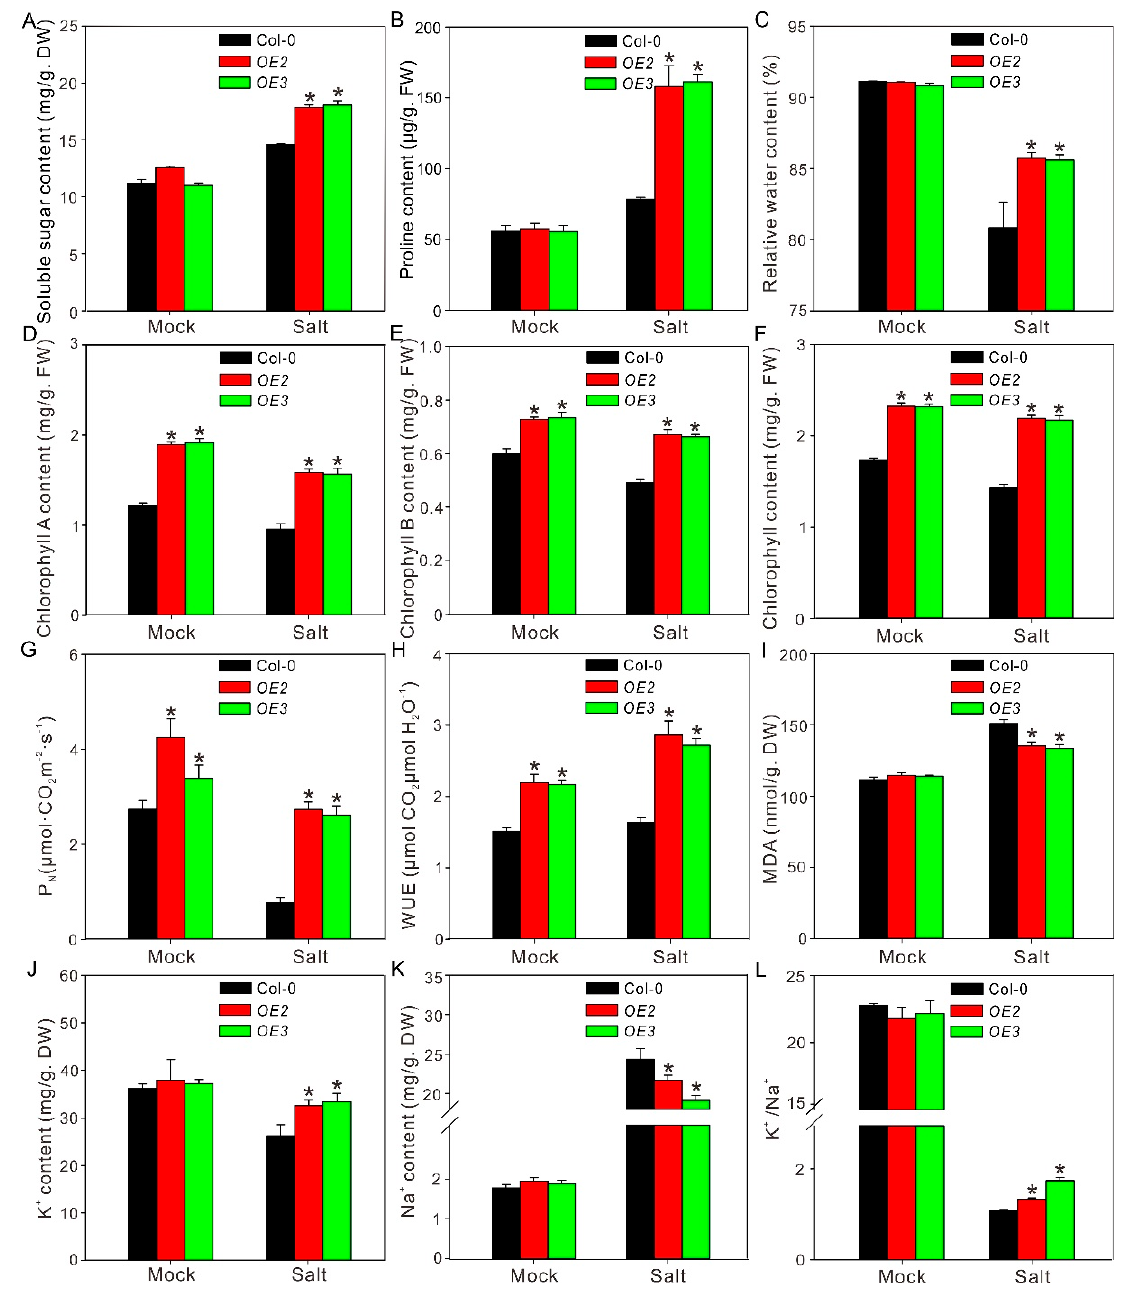
Figure 4. Several physiological parameters of the salt-treated wild-type and transgenic plants. Soluble sugar content ( A ), proline content ( B ), relative water content ( C ), chlorophyll A content ( D ), chlorophyll B content ( E ), chlorophyll content ( F ), net photosynthetic rate (Pn) ( G ), water-use efficiency (WUE) ( H ), content of malondialdehyde (MDA) ( I ), K + content ( J ), Na + content ( K ), and K + /Na + ( L ) were tested. Asterisks indicate significant differences from Col-0 (Values are mean ± SE of three replicates. * p < 0.05, one way ANOVA).